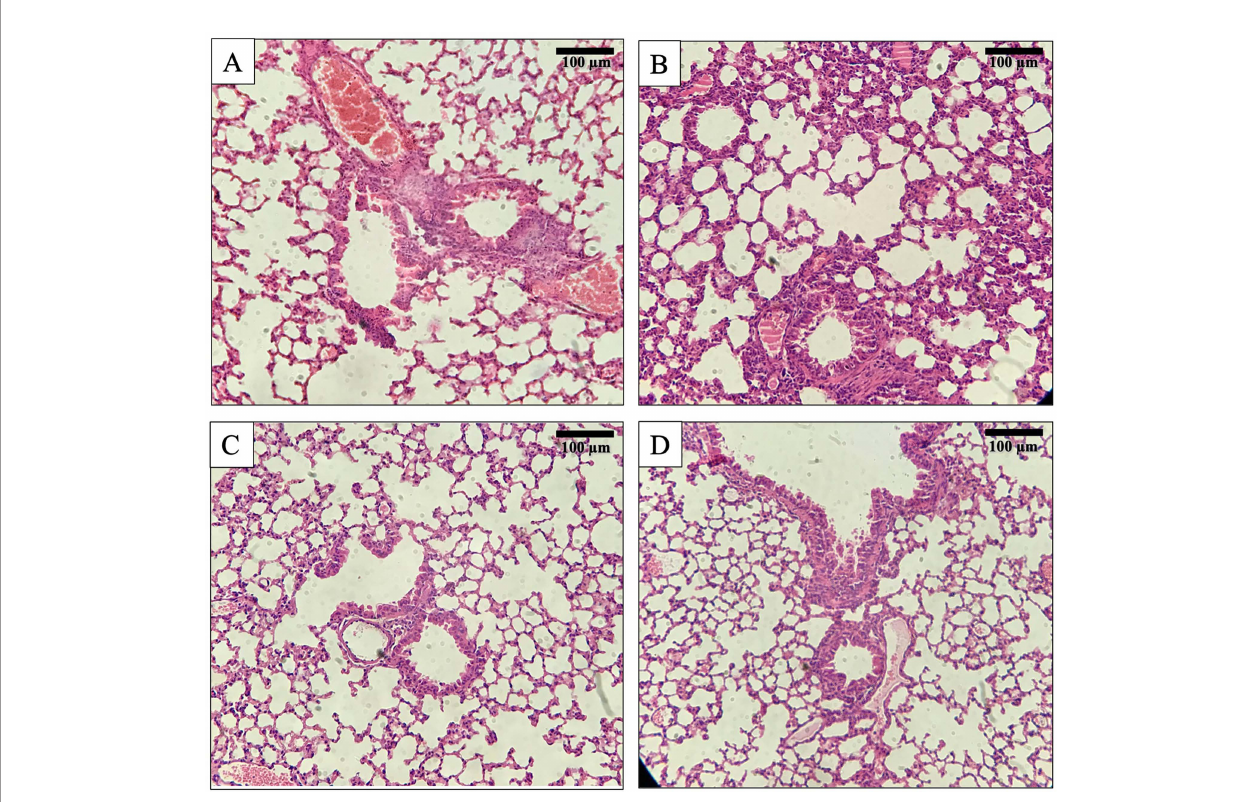
FIGURE 4 | Histology of mouse lung tissue sections after Hematoxylin and Eosin (H&E) staining at 200x magni fi cation. (A) Lungs ’ tissue of a normal mouse. (B) Lungs ’ tissue of bacteria K pneumoniae (Kp56) infected mouse showing interstitial in fi ltration by neutrophils and macrophages with rupture of alveoli. (C) Lungs ’ tissue of mouse treated with øKp_Pokalde_002 via IP route. (D) Lungs ’ tissue of mouse treated with øKp_Pokalde_002 via oral